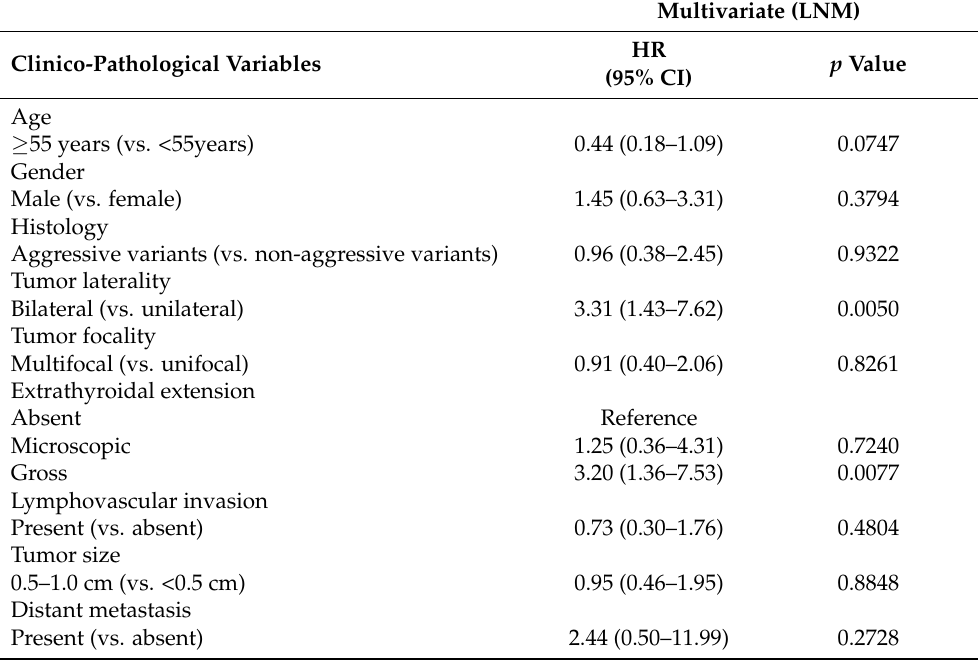
Table 3. Multivariate analysis using a logistic regression model for predictors of lymph node metasta- sis (LNM) in PTMC.